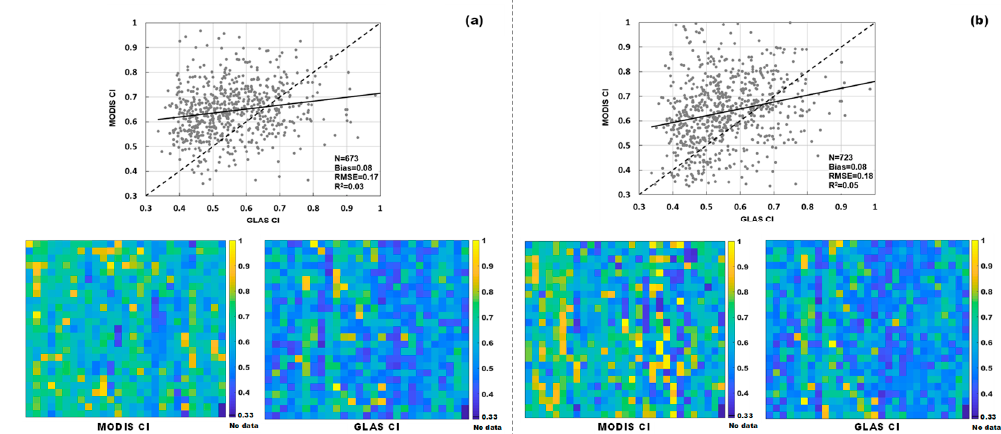
Figure 10. Scattering plots of the comparison between GLAS CI and MODIS CI and the corresponding CI distribution pattern. ( a ) is the comparison between GLAS CI and V005-MODIS-CI; ( b ) is the comparison between GLAS CI and V006-MODIS-CI.